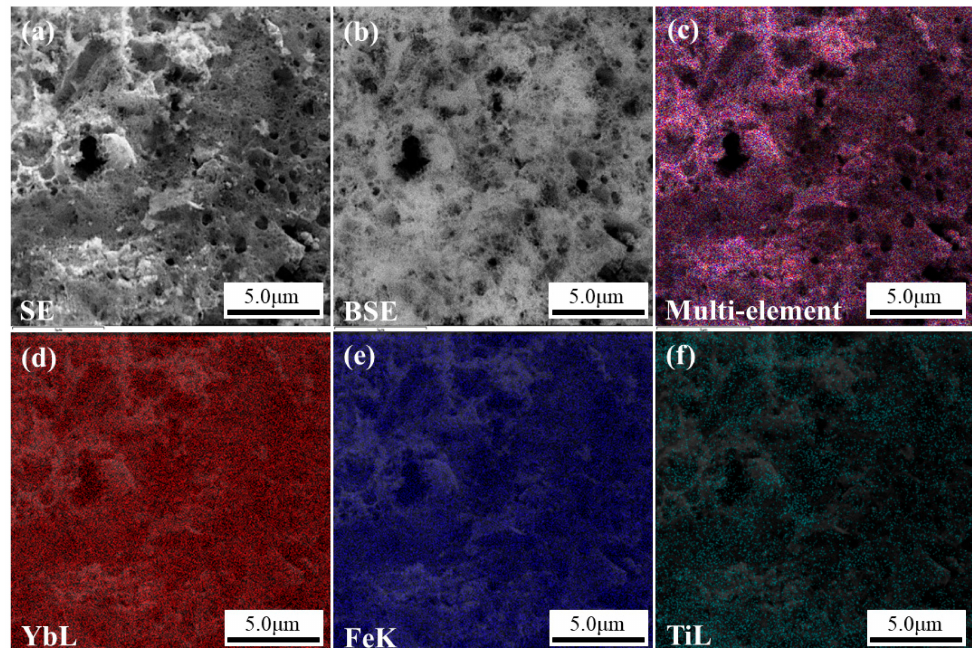
Figure 2. SEM images obtained on SE ( a ) and BSE ( b ) detectors and EDXS multi-element ( c ) and single element ( d –Yb, e –Fe, f –Ti) mapping of a sample containing 5 mol.% of TiO 2